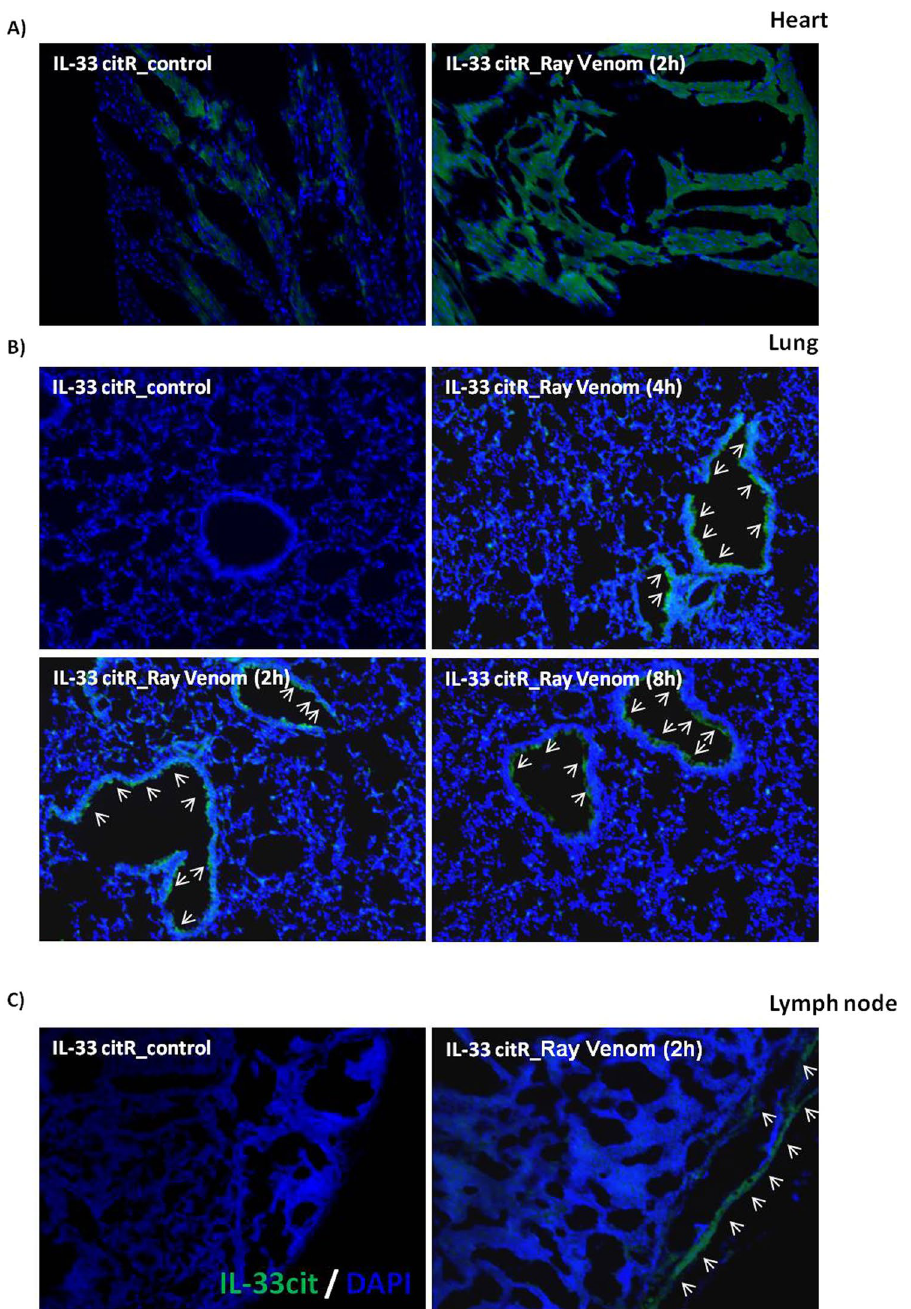
Figure 6. Stingray venom induces IL-33 in heart and lung tissues. Venom (300 μ g/ml) in 500 μ l or sterile saline were injected i.p. into C57BL/6 WT or IL-33/citrine reporter (citR) mice. After 2, 4 or 8 h, mice were anesthetized with a ketamine (50 mg/ml)/xylasine (25 mg/ml) and perfused through the ascending aorta with saline followed by 4% paraformaldehyde. After perfusion, heart ( A ), lung ( B ) and lymph nodes ( C ) were removed and post fixed for two months. For cryosectioning, fixed organs were transferred to 40% sucrose in phosphate buffer, mounted in OCT compound (Neg-50, Richard Allan), sectioned at 15 μ m on a cryotome (Cryostat HM 505E), and processed for immunofluorescence. All sections were stained with DAPI. IL-33- produncing cells (indicated by arrows) were imaged with an inverted fluorescence microscope (Olympus BX51 at 10x). Scale bar = 200 μ